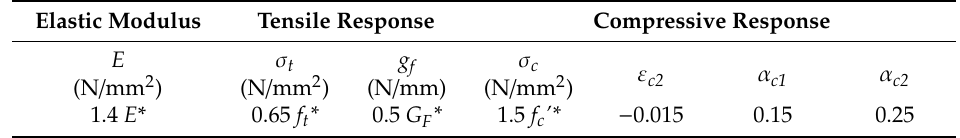
Table 1. Calibrated model parameters for normal spring.